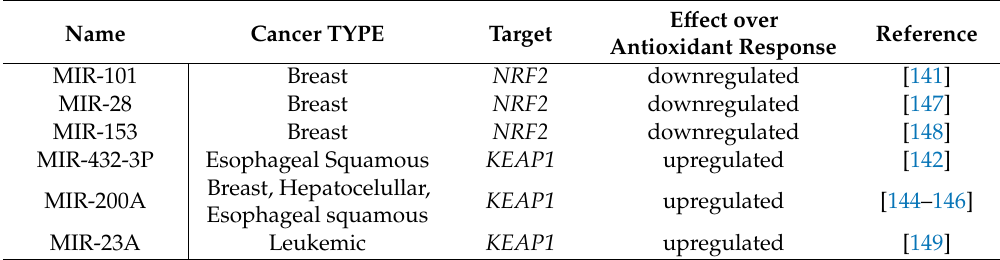
Table 2. MicroRNAs involved in the antioxidant response in cancer